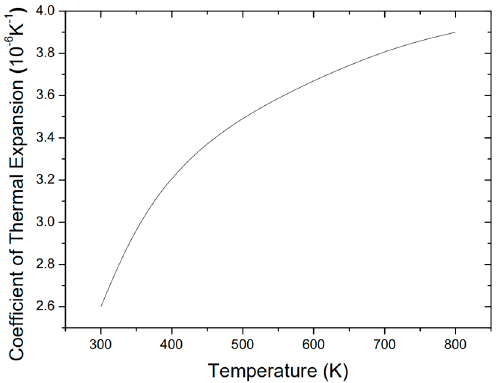
Figure 3. Thermal expansion coefficient of silicon.